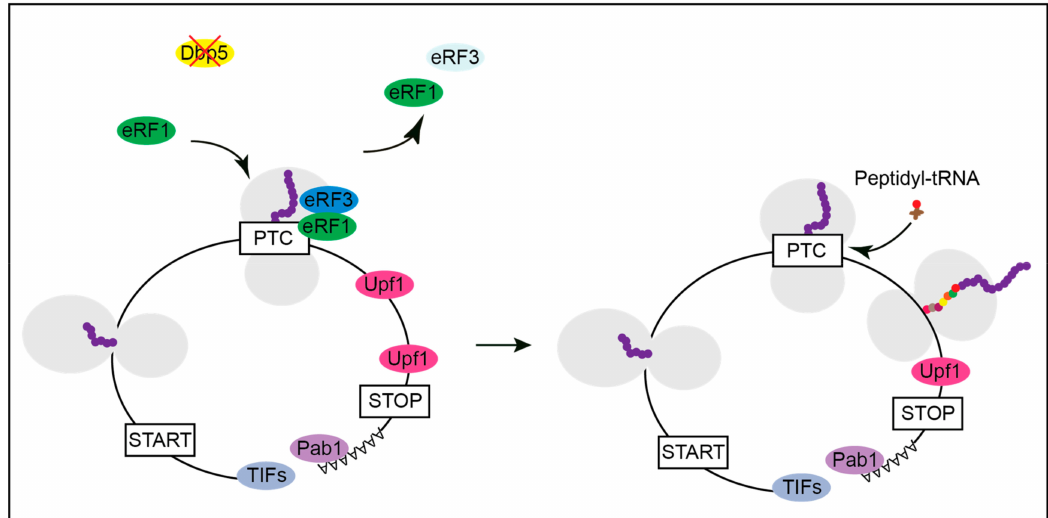
Figure 5. A ff ecting the availability of functional Dbp5 might generate full length proteins from PTC containing mRNAs. With a reduced function of Dbp5, the stop codon recognition of eRF1 and eRF3 is impaired. If the PTC is not recognized as a stop codon, a near cognate peptidyl-tRNA enters the ribosome, and translation elongation continues. A normal stop codon is less susceptible to translational readthrough than a PTC, presumably due to additional factors that promote translation termination, such as Pab1. Hence, there is a high probability that translation can terminate at the correct stop codon rather than at the PTC. This will most likely generate a full-length protein with only one amino acid exchange instead of a truncated